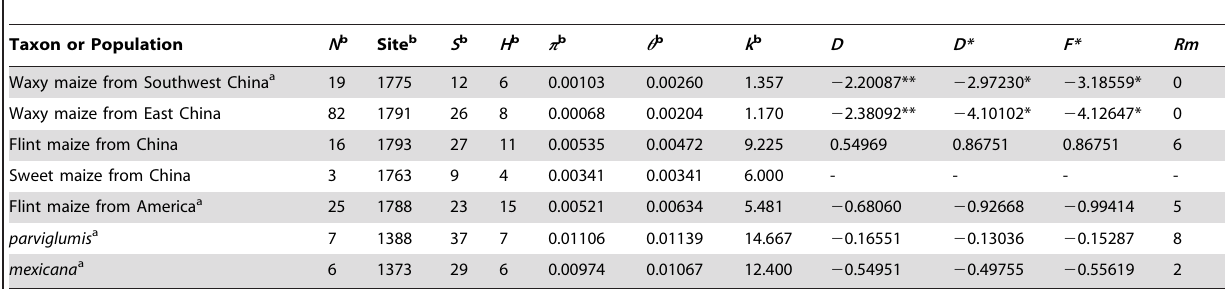
Table 3. Summary of nucleotide diversity within maize taxon or